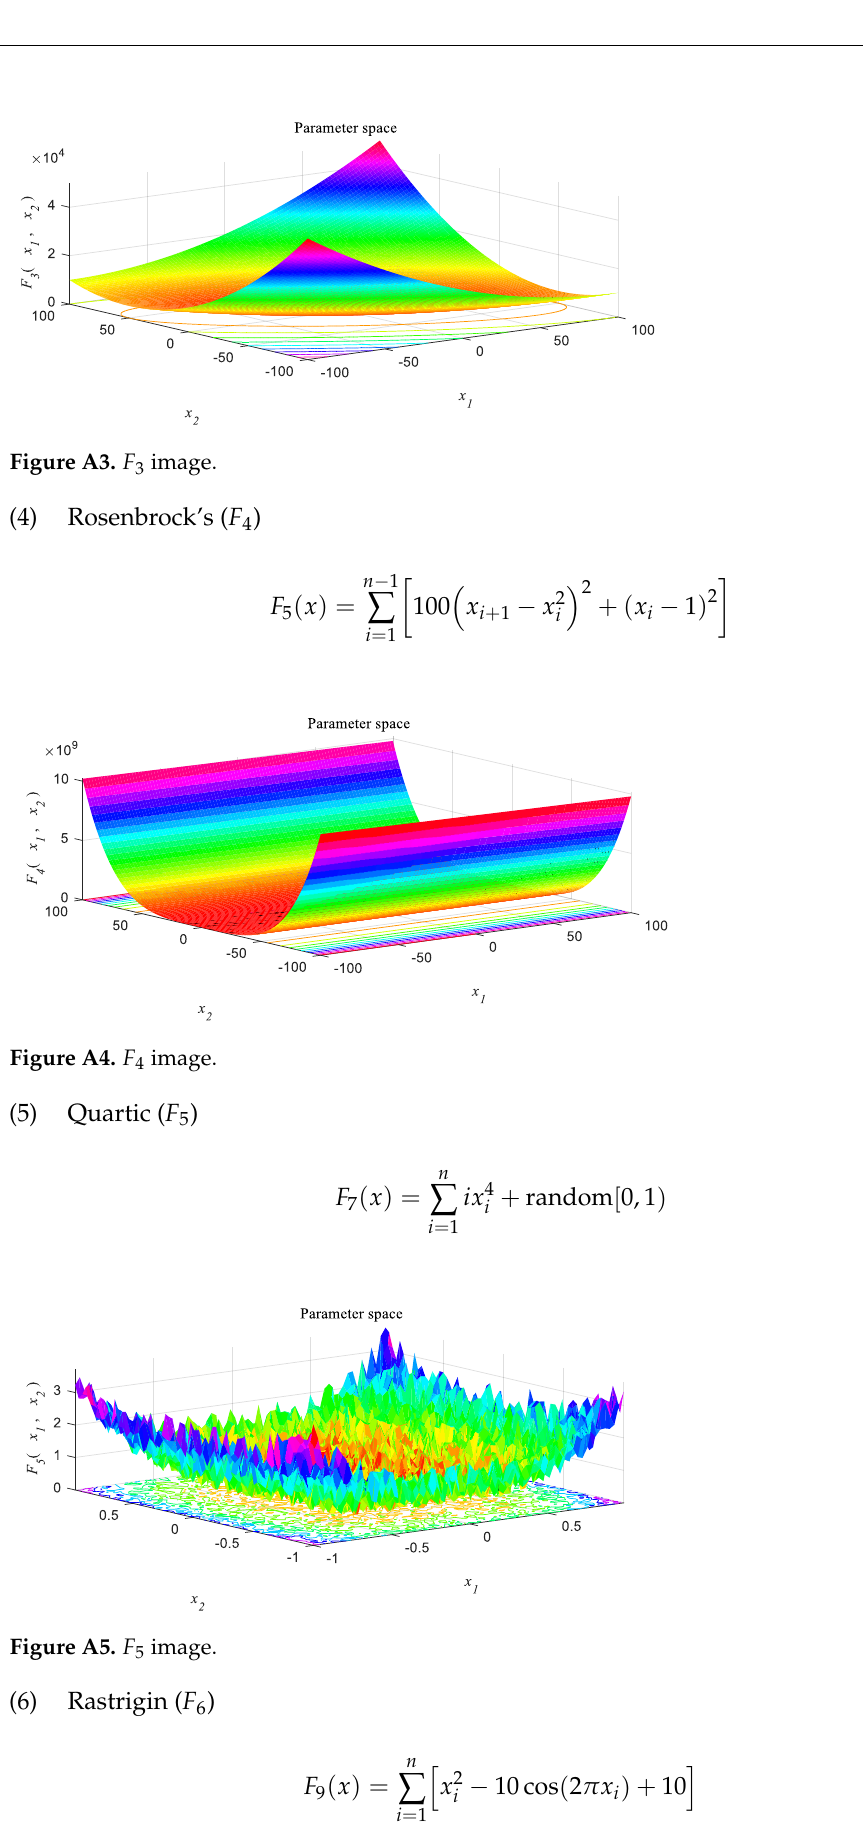
Figure A5. F 5 image.